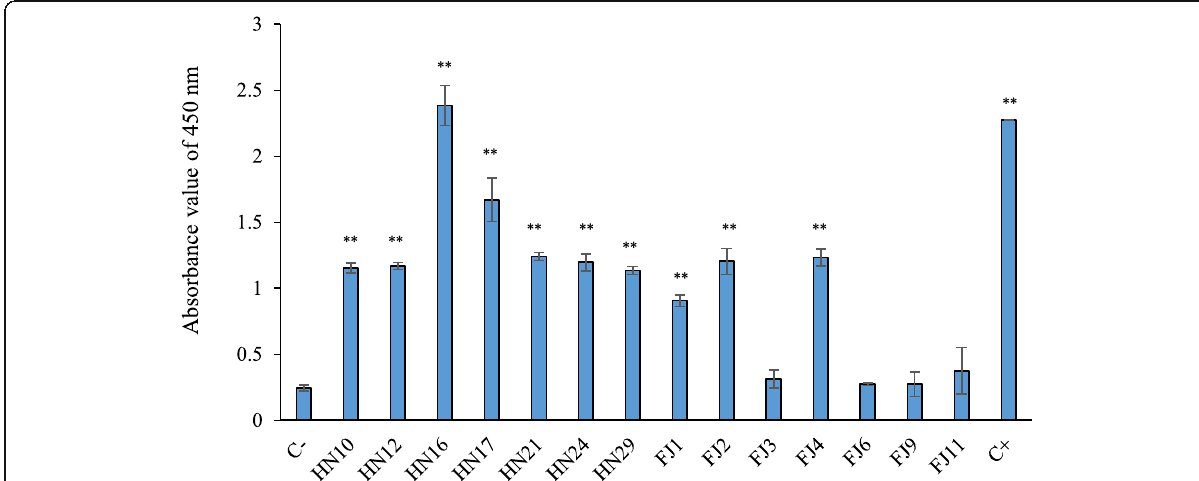
Fig. 4 Cassava samples collected from Hainan and Fujian Provinces in China were analyzed by ELISA using SLCMV CP polyclonal antibody. C – , healthy cassava sample; C + , SLCMV-Col-infected cassava sample. Values are mean ± SD ( n = 3). (Student ’ s t -test; ** P <